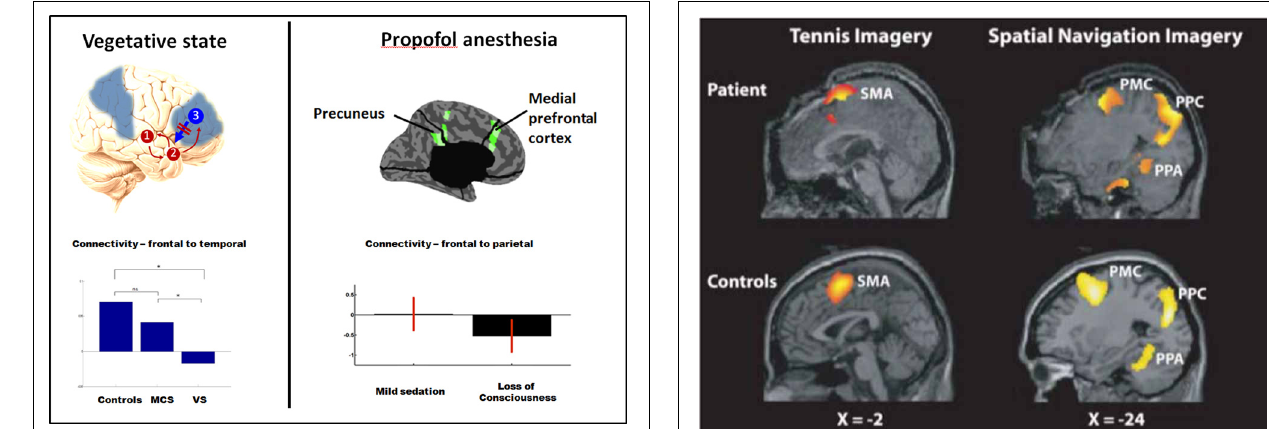
impairments of consciousness ( Figure 1 ). New refinements of